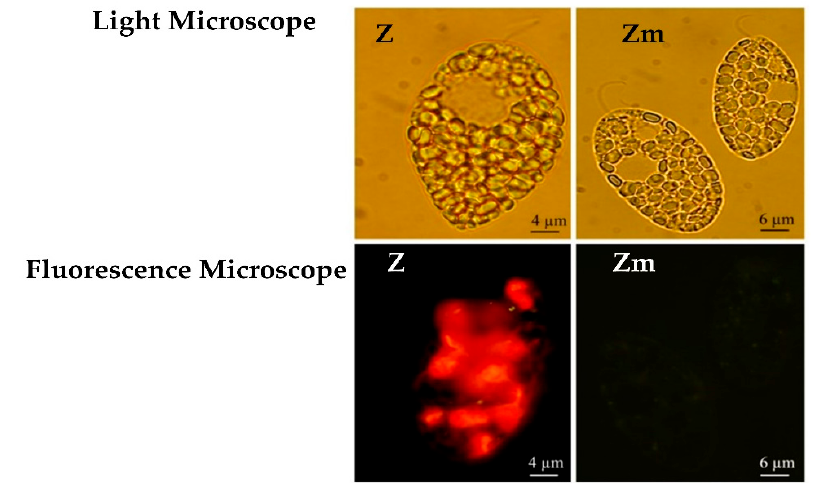
Figure 2. E. gracilis strains visualized under the light microscope and fluorescence microscope. Red fluorescence from the chlorophyll in the chloroplasts appears only in the Z-strain.